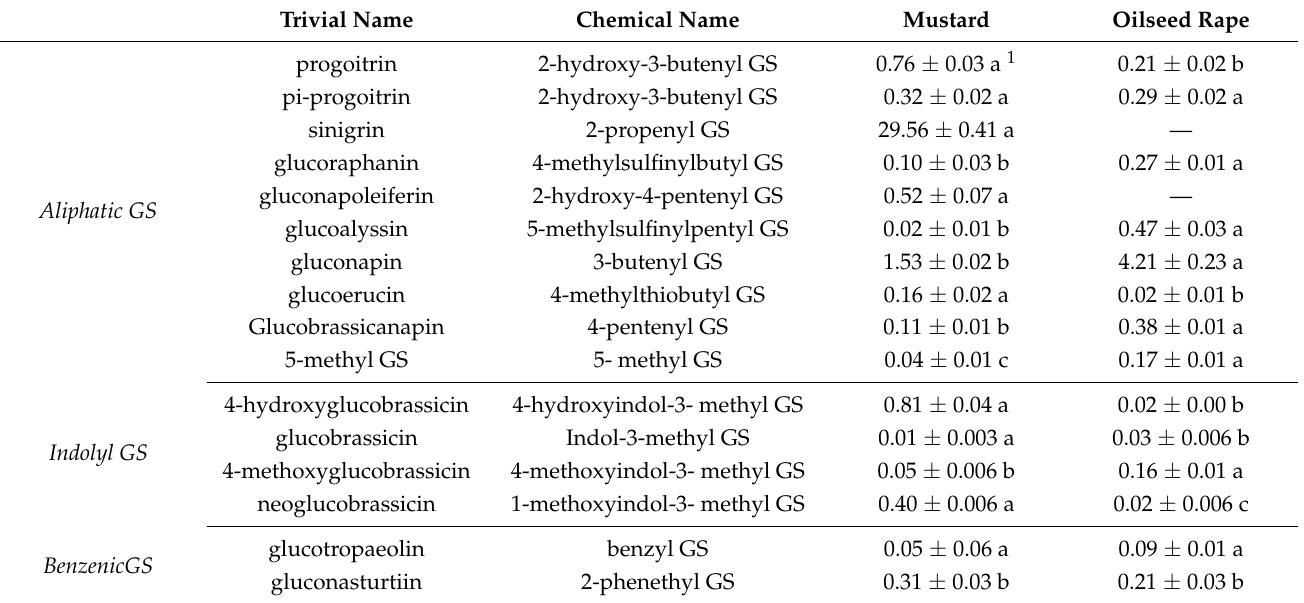
Table 2. Glucosinolate concentration ( µ mol · g − 1 DW) in the tissues of different biofumigation materials.